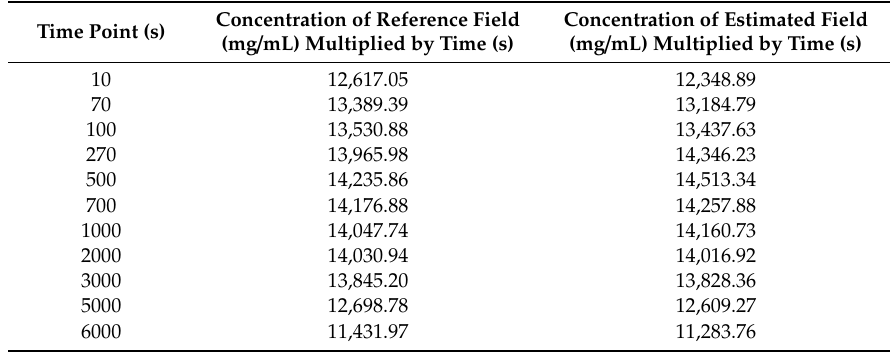
Table 1. Total mass concentration at each time point.